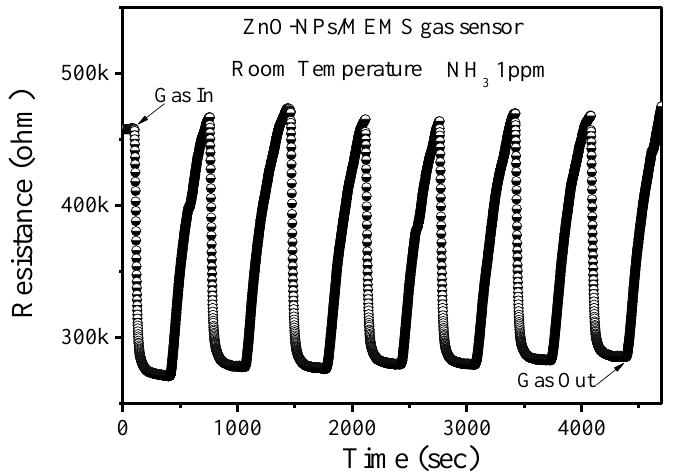
Figure 6. Response for a ZnO-NPs/MEMS NH 3 sensor that is exposed to 1 ppm NH 3 at room tem- perature.